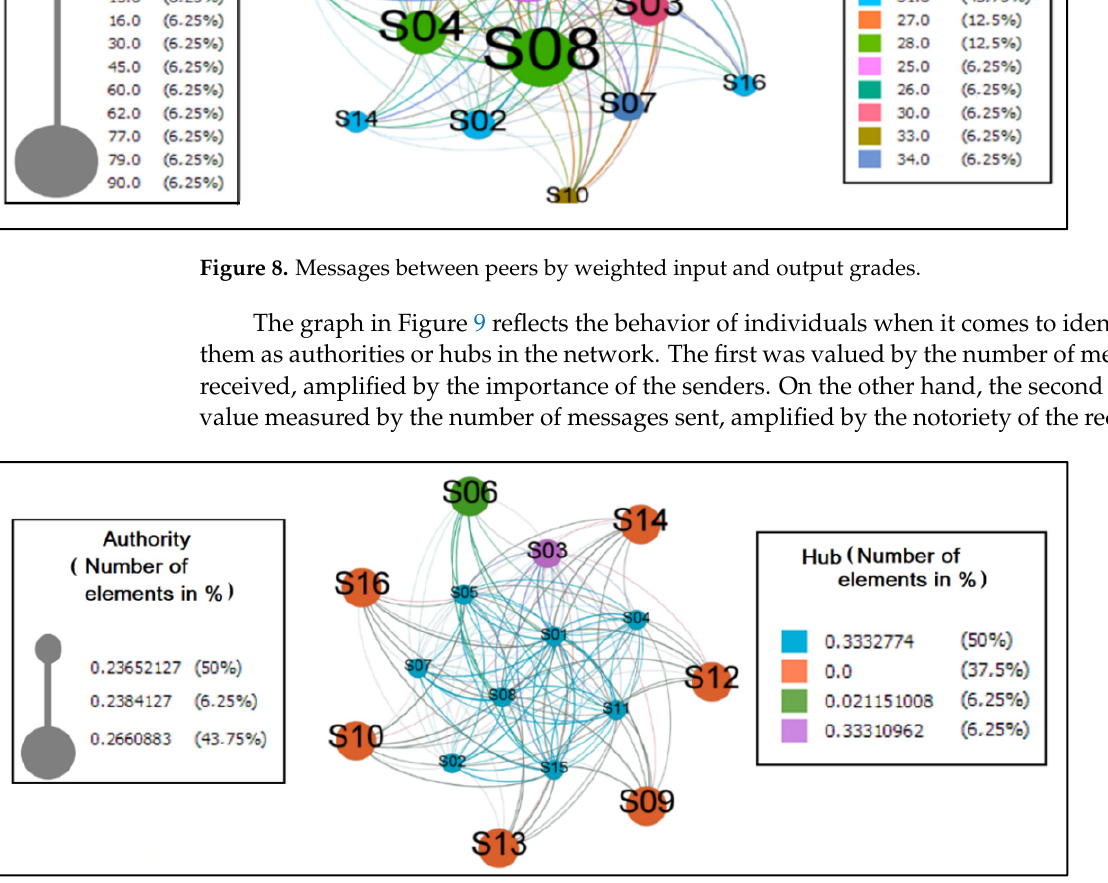
Figure 10. Collaborative Practices Carried Out in ColaborAtiva.